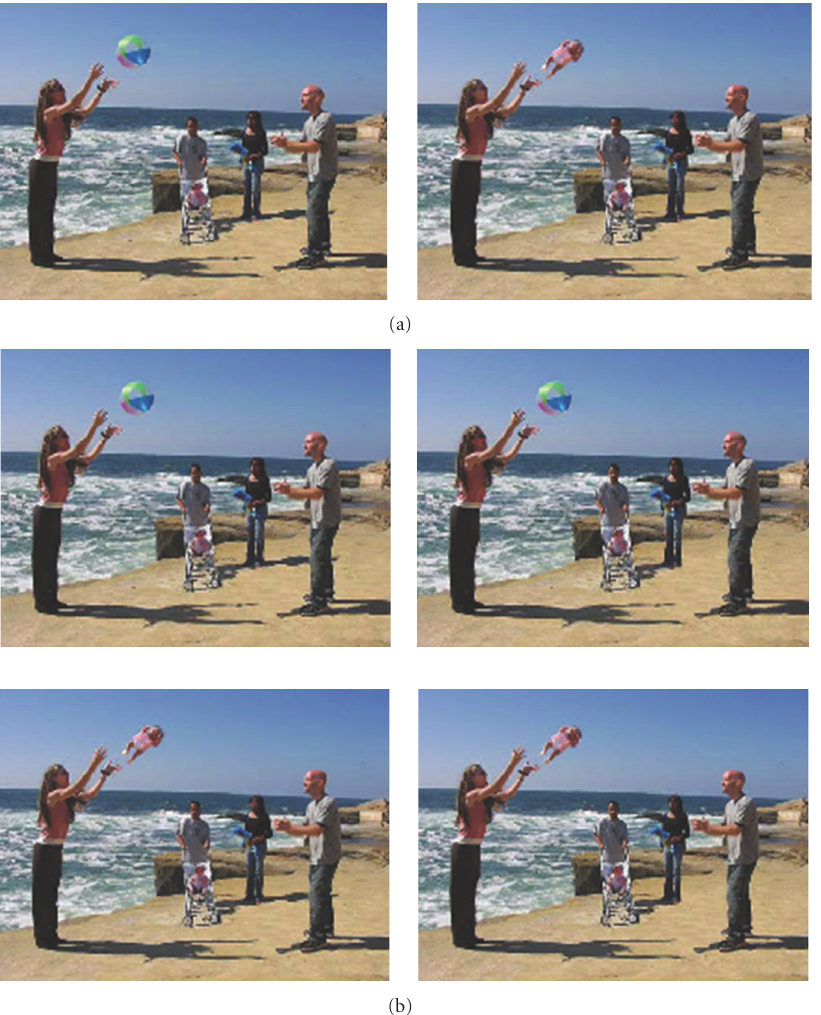
Figure 1: (a) Example stimuli for the WOW task. Picture on the left is the “normal” picture. Picture on the right is the “weird” picture. This picture was digitally manipulated in which the beach ball in midair is replaced by a baby. (b) Example stimuli for the STD task. The stimuli pair could either be two normal pictures (top two) or two “weird” pictures (bottom two). The detail missing pictures are shown on the right of the picture pairs; the shadow of the woman in the background was digitally